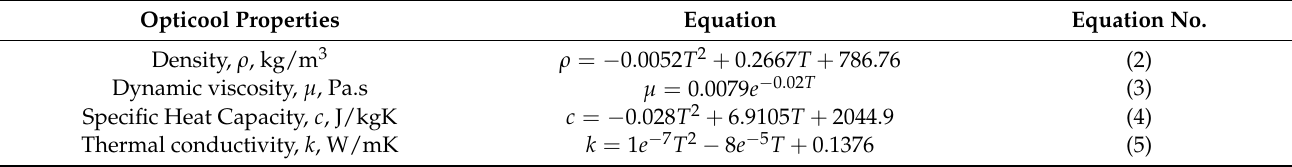
Table 2. List of properties for SMC and copper